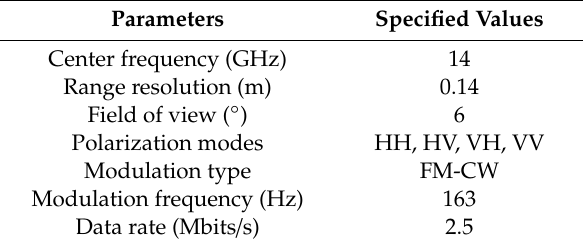
Table 2. Main parameters of Tomoradar. FM-CW: Frequency Modulated Continuous Wave. Parameters